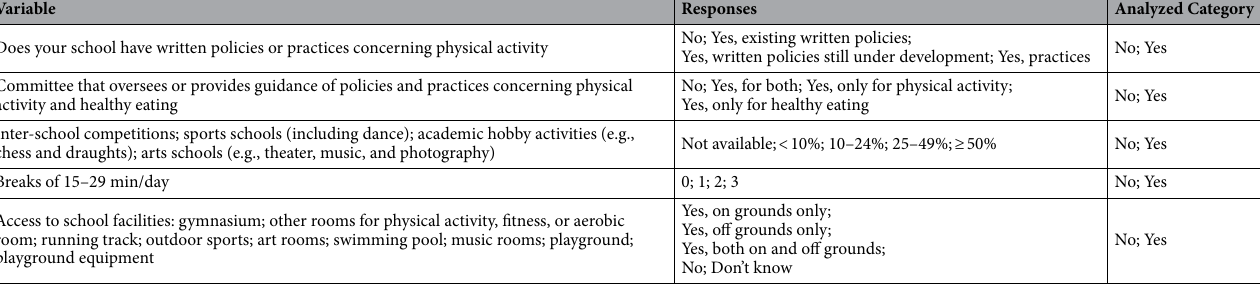
Table 1. Indicators of the school